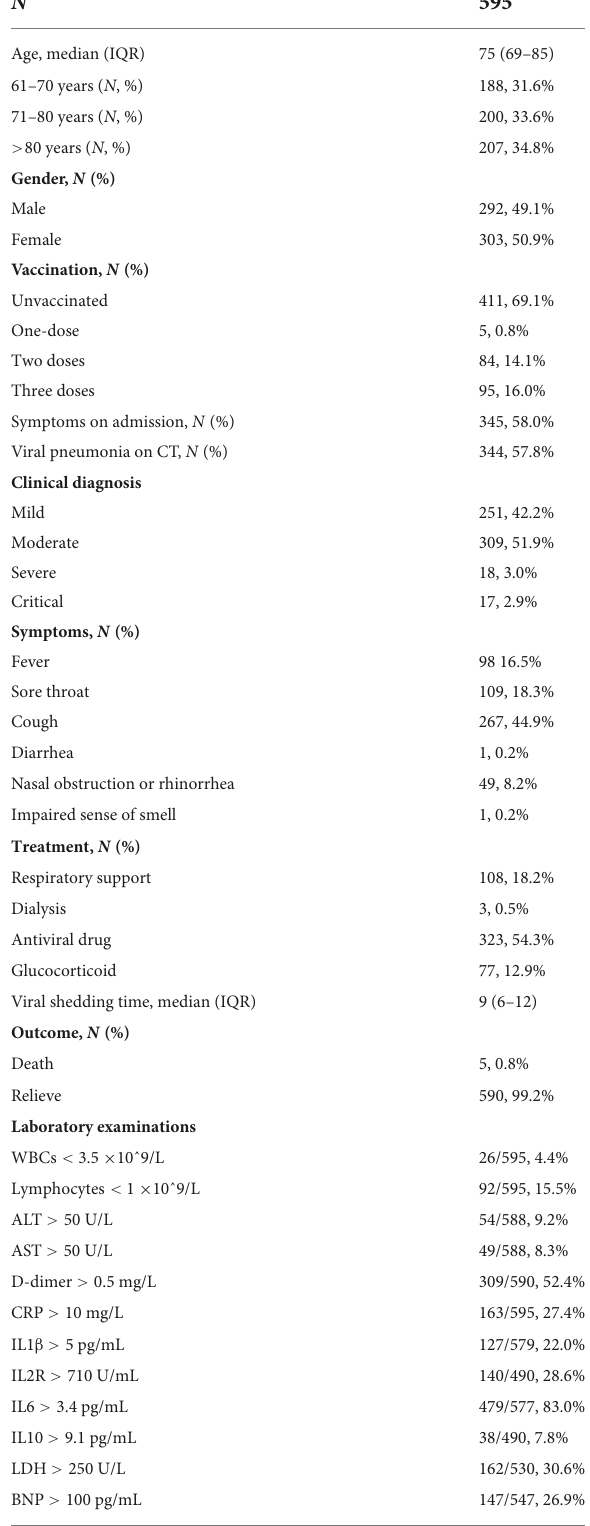
TABLE 1 The basic characteristics of the enrolled